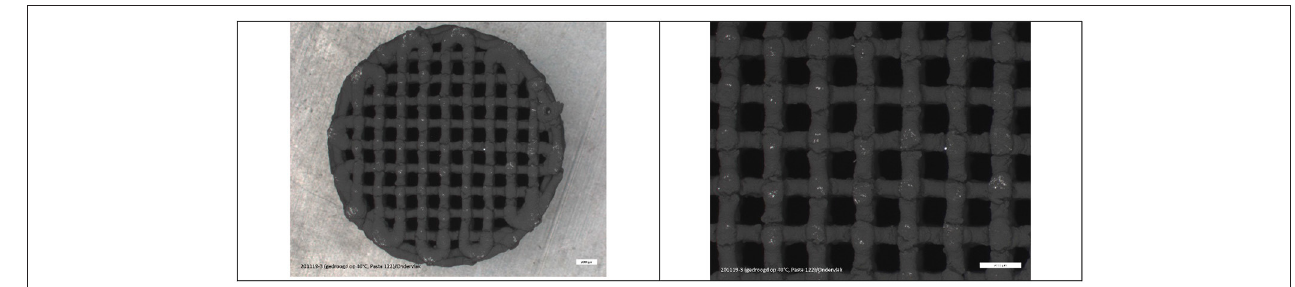
FIGURE 2 | Top view of 3D printed CNT-PEI-UBE-PVA structure.